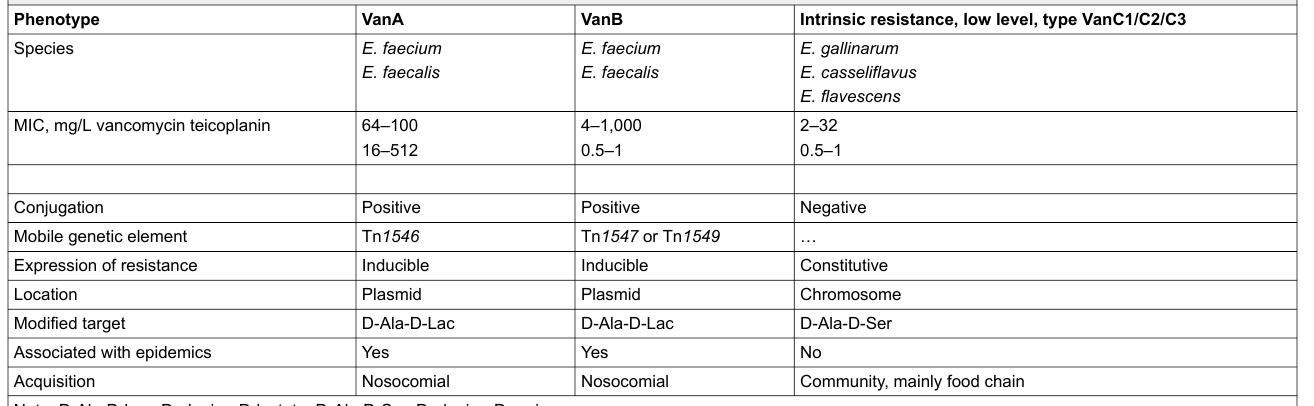
Table 1: Clinically important vancomycin-resistant